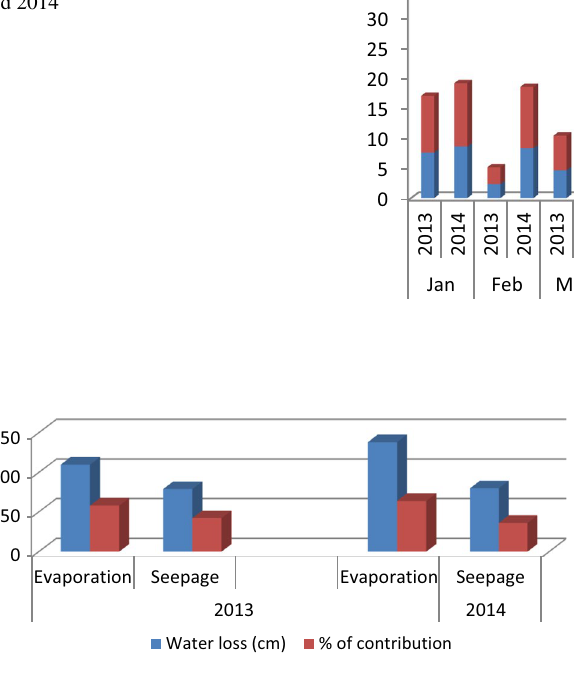
Fig. 5 Total seepage and % contribution for water loss from the pond of each month of 2013 and 2014